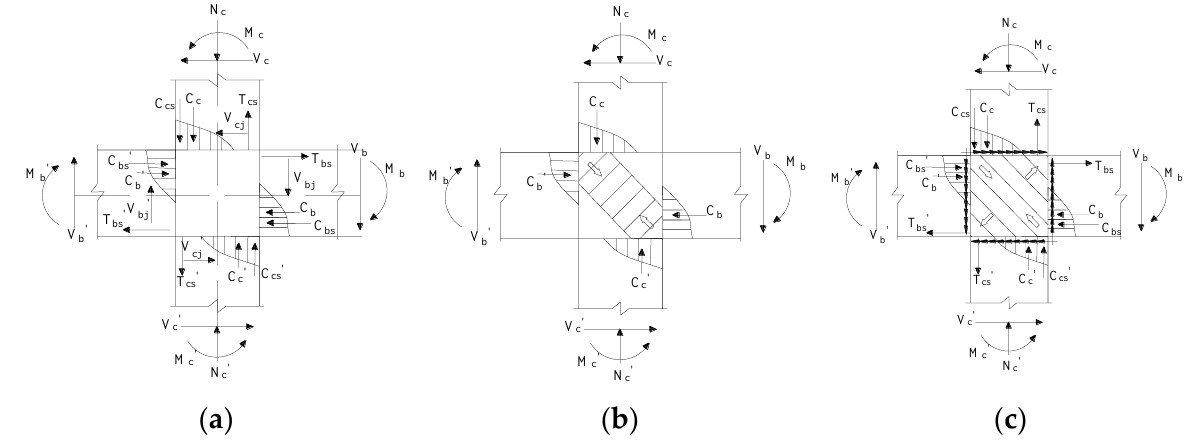
( c ) Figure 13. Maximum strains of GFRP hoops. ( a ) Stirrup ratio group; ( b ) Axial pressure ratio group; ( c ) Concrete strength group. 4. Calculation of Load Carrying Capacity 4.1. Nodal Core Shear Bearing Capacity The reinforced concrete beam-to-column joint is very complex in terms of forces, and the core force transfer mechanism is shown in Figure 14. Its complex hysteretic behavior can be simulated by means of recent accurate and efficient models [18]. In the beam-to- column joint, there are two types of force transmission mechanisms: the inclined compres- sion rod mechanism and the truss mechanism [19]. The diagonal compression bar mech- anism (shown in Figure 14b) means that when the joint is subjected to an external load, the concrete pressure C b at the beam end and the concrete pressure C c at the column end